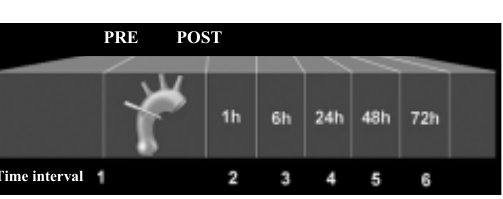
Fig. 2 – Scheme of the time intervals of collection of